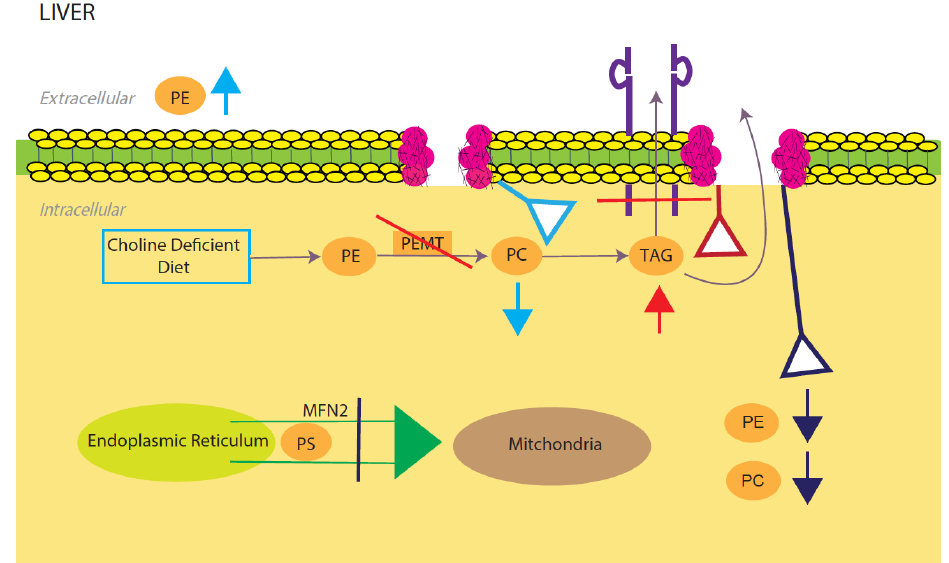
Figure 2. Model for phosphatidylcholine (PC)/phosphatidylethanolamine (PE)-induced fatty liver disease. Light blue, red, and dark blue are three different PE/PC membrane disruption pathways. Light blue shows the effects of a low choline diet, which significantly lowers intracellular PC levels due to lack of its primary reactant. The liver will try to compensate for this lowering by in- creasing extracellular PE. Red shows the effects of disrupting the PEMT pathway, which significantly decreases TAG secretion and increases TAG intracellular accumulation. Dark blue shows the effects of silencing the expression of mitochondrial protein Mfn2. In the ER, PS is converted to PE, which is then sent into the mitochondria for modification to PC. Knocking out this membrane protein causes a NAFLD/NASH phenotype due to the halting of PE and PC creation. All three disruptions upset the intracellular PE/PC ratio, which in turn causes membrane